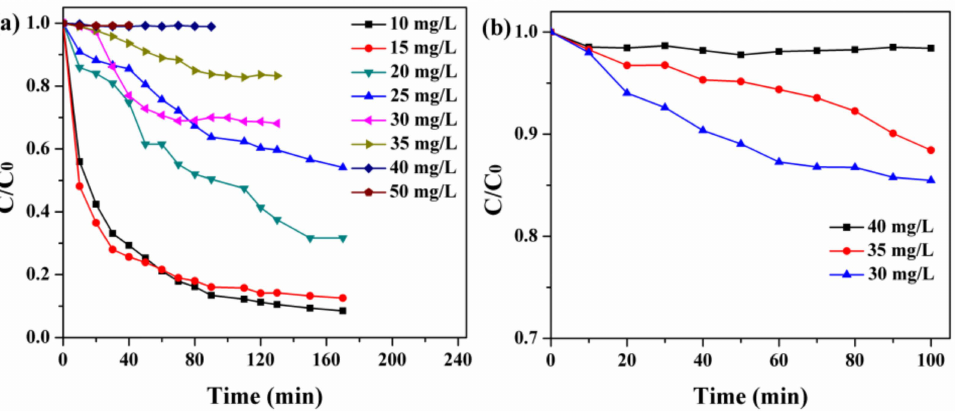
Figure 7. ( a ) Adsorption of Rhodamine B (RhB) with varying concentrations over BiOI (40 mg) and ( b ) NH 2 -MIL-125(Ti) (40 mg) in 100 mL solution at room